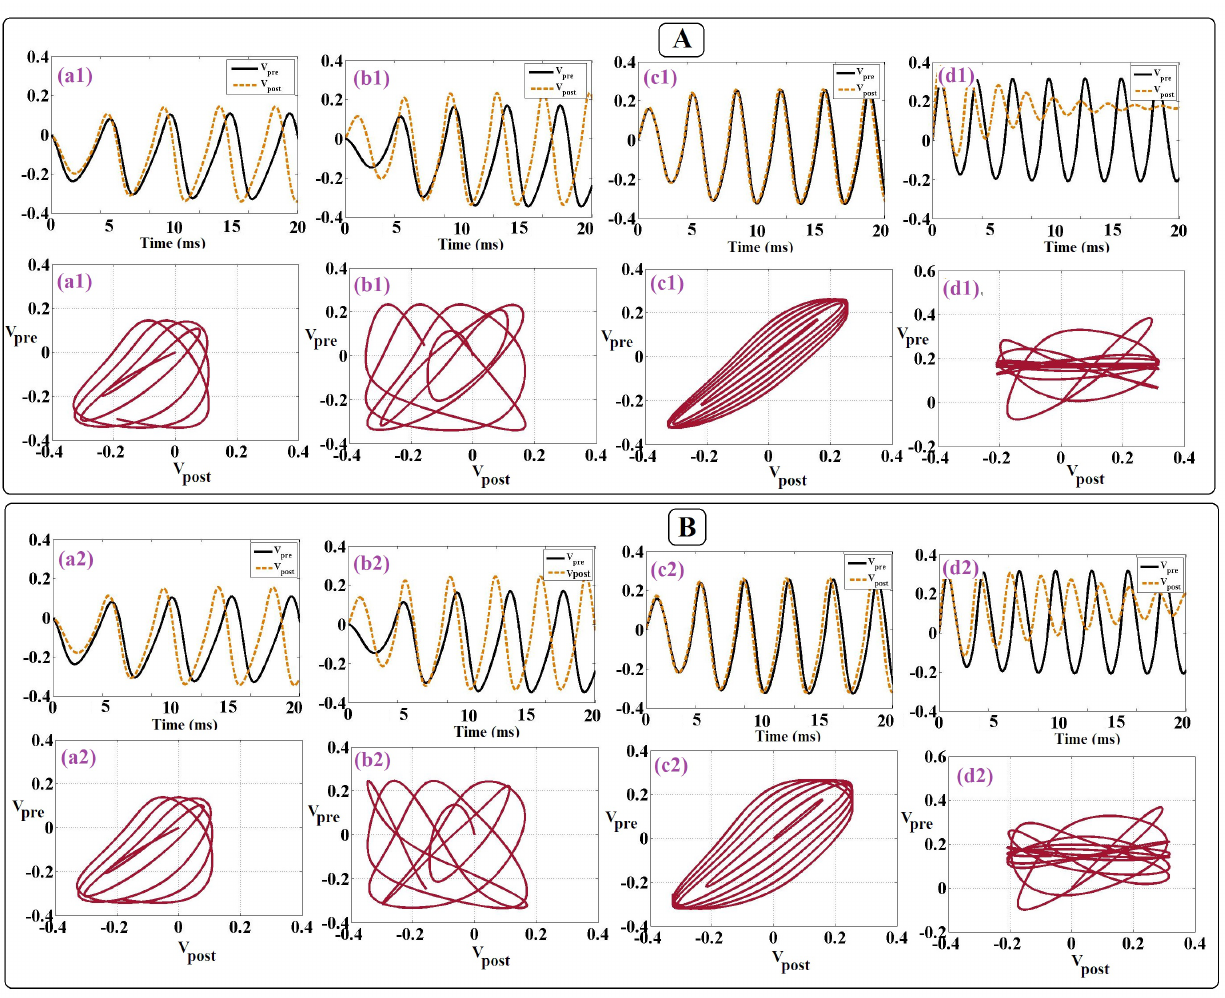
Figure 6. Time domain and dynamical portrait for two coupled DSSN models: ( A ) Original DSSN- coupled models that correspond to ( a 1 – d 1 ); ( B ) Proposed DSSN-coupled models by ( a 2 – d 2 ). These patterns are evoked by different stimulus as: I Stimulus = 0.1, I Stimulus = 0.2, I Stimulus = 0.5, and I Stimulus = 1,